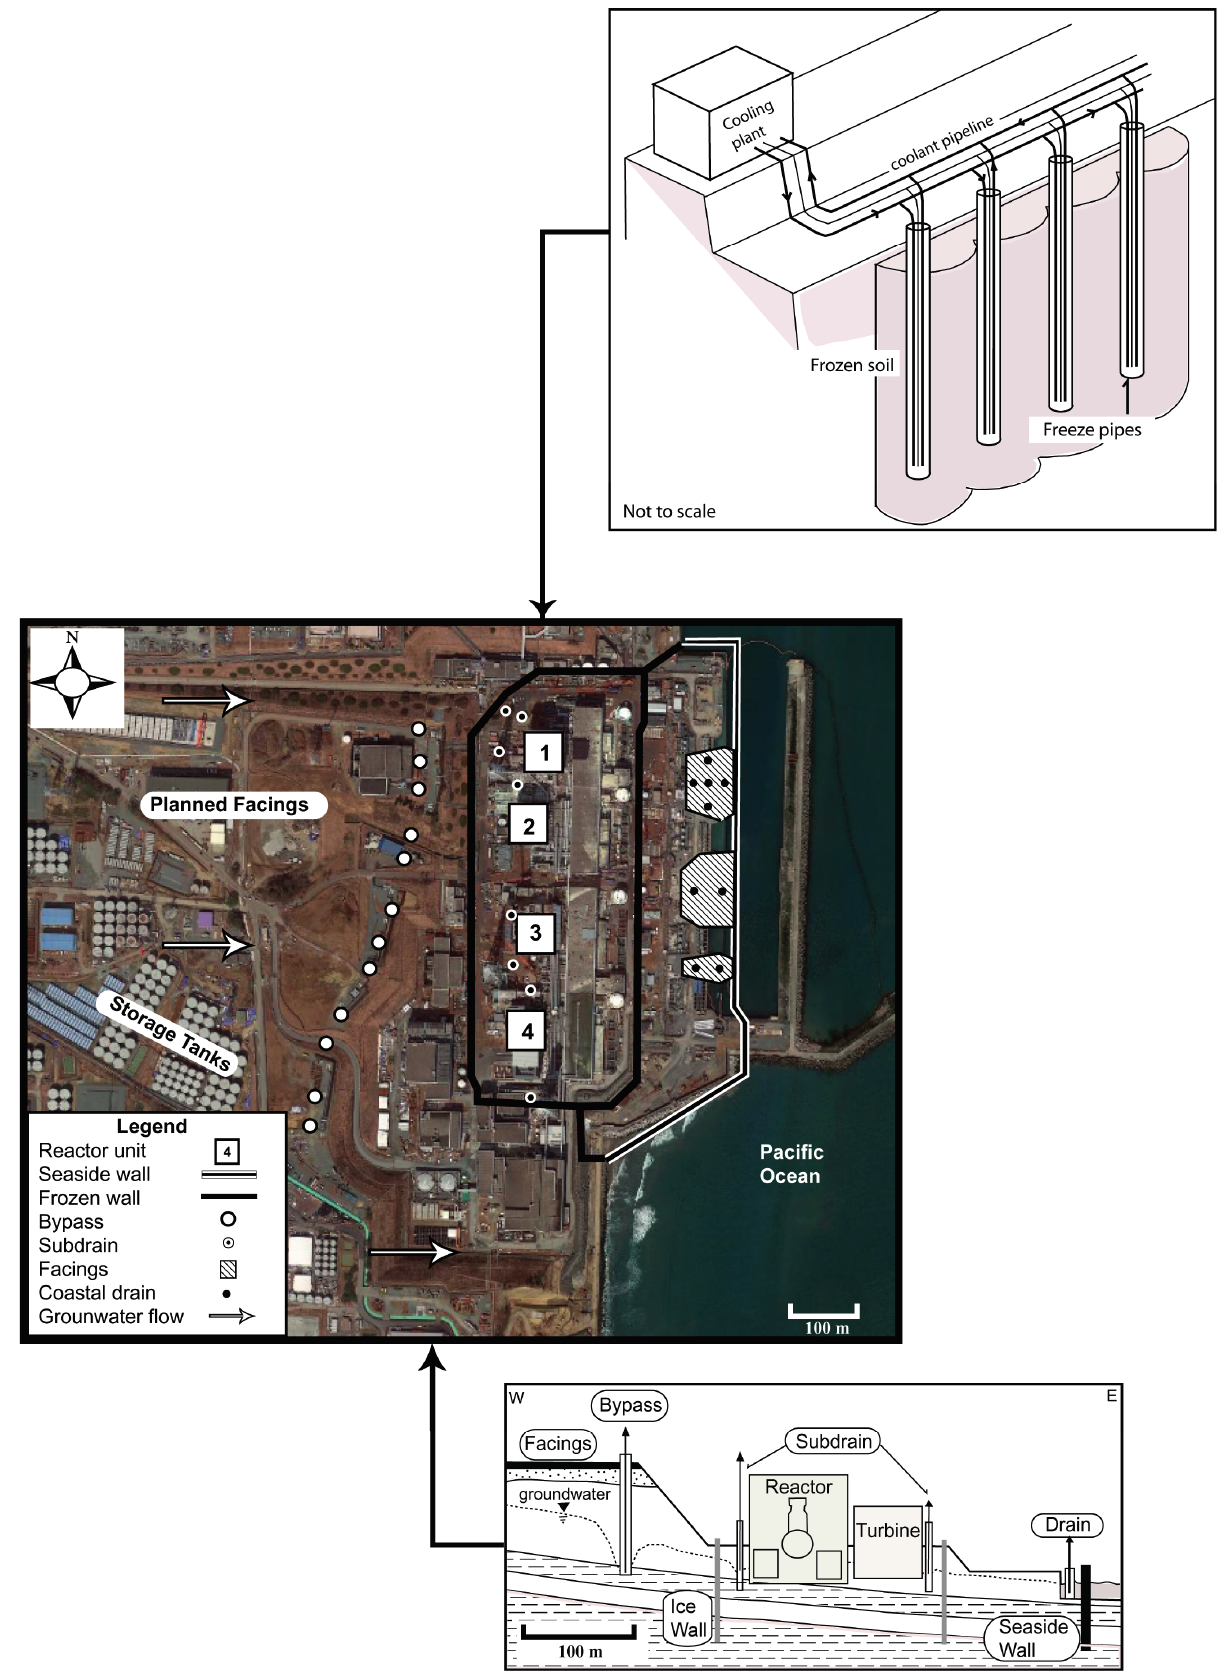
Figure 1. Outline of measures implemented to manage groundwater contamination at the Daiichi nuclear